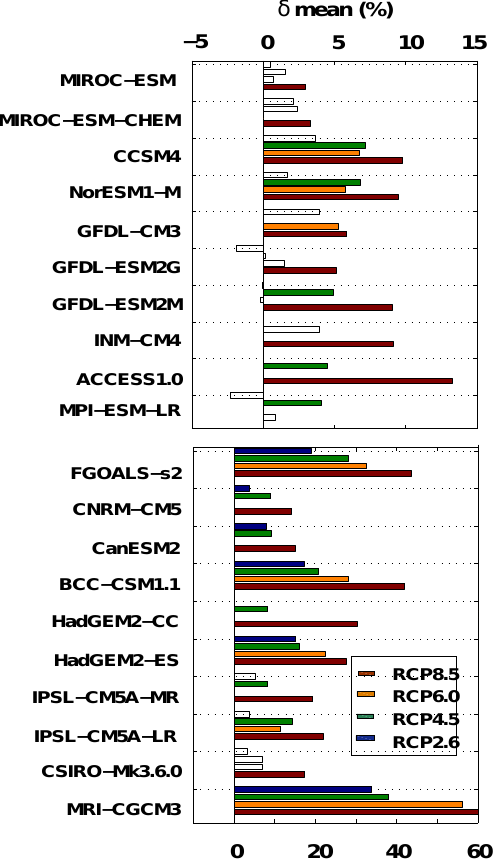
Fig. 7. Percentage change in mean rainfall per degree change in Fig. 6. Percentage change in mean rainfall for RCP-8.5 (red), RCP- temperature for RCP-8.5 (red), RCP-6.0 (orange) and RCP-4.5 6.0 (orange), RCP-4.5 (green) and RCP-2.6 (blue) for all models (green) for all models. As the temperature change in RCP-2.6 is under consideration. Relative change is calculated as the change in very small, it is not taken into consideration. Transparent bars are seasonal (JJAS) mean rainfall for the period 2070–2100 with respect the values that are not significant at 95% confidence (cid:19) (cid:18) JJASrain 2070 − 2100 · 100 − 100. The to the period 1870–1900, i.e., JJASrain 1870 − 1900 gap separates models with rainfall values for 1871–2004 lying within and outside twice the standard deviation of the observed mean as per Fig. 1. Bars on the panels are transparent if the δ mean values are not significant at 95% confidence level.